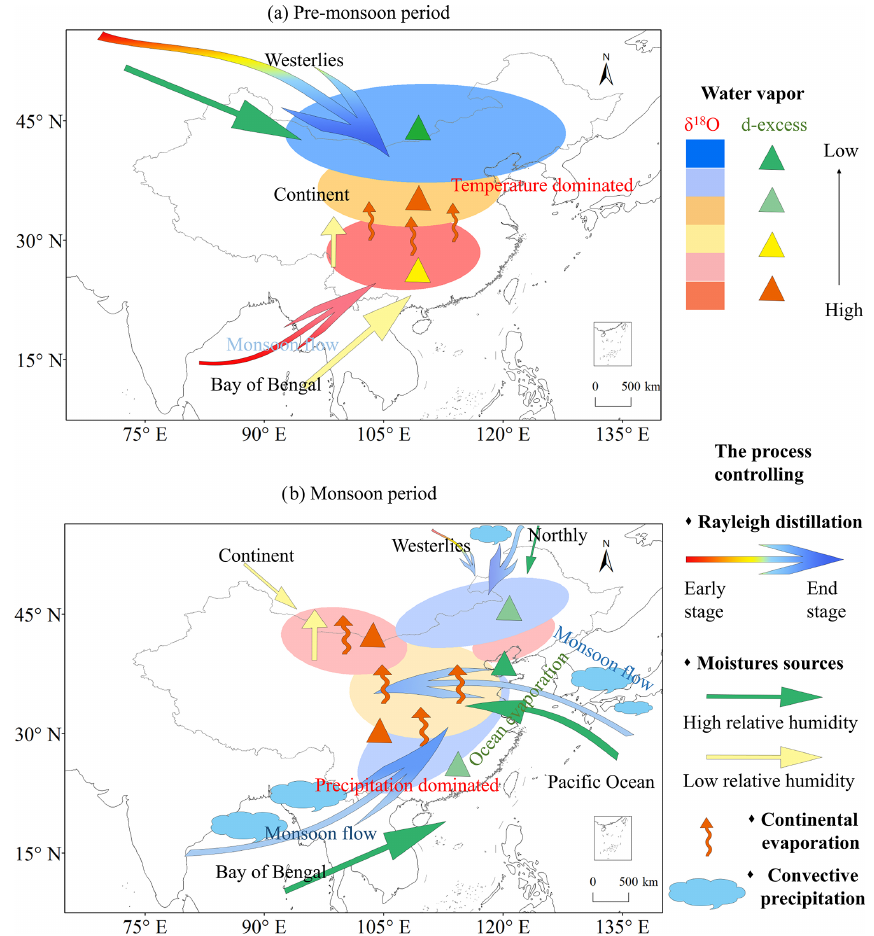
Figure 13. Schematic picture summarizing the different processes controlling the observed spatial patterns and seasonality of vapor isotopes. Color gradient arrows from red to blue represent the initial to subsequent extension of the Rayleigh distillation process along the water vapor trajectory, corresponding to high to low values of δ 18 O. The green arrows represent high relative humidity, the yellow arrows represent low relative humidity, the orange twisted arrows represent continental recycling, blue clouds represent strong and weak convective processes, green triangle series represents low values of d-excess; and the yellow triangle series represents high values of